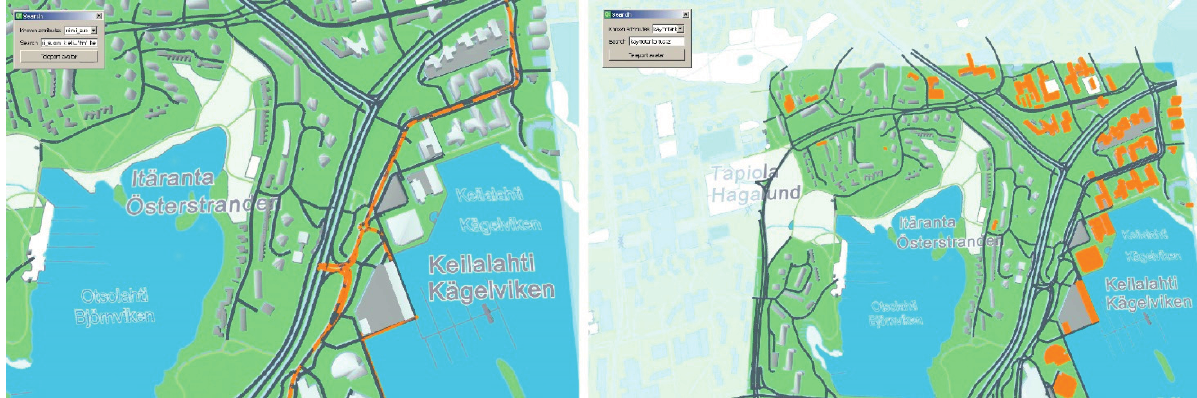
Figure 8. On left: Searching all road objects where the name contains a given string. On right: Searching all buildings marked in the data as commercial-use buildings. The objects that were located are highlighted in orange.